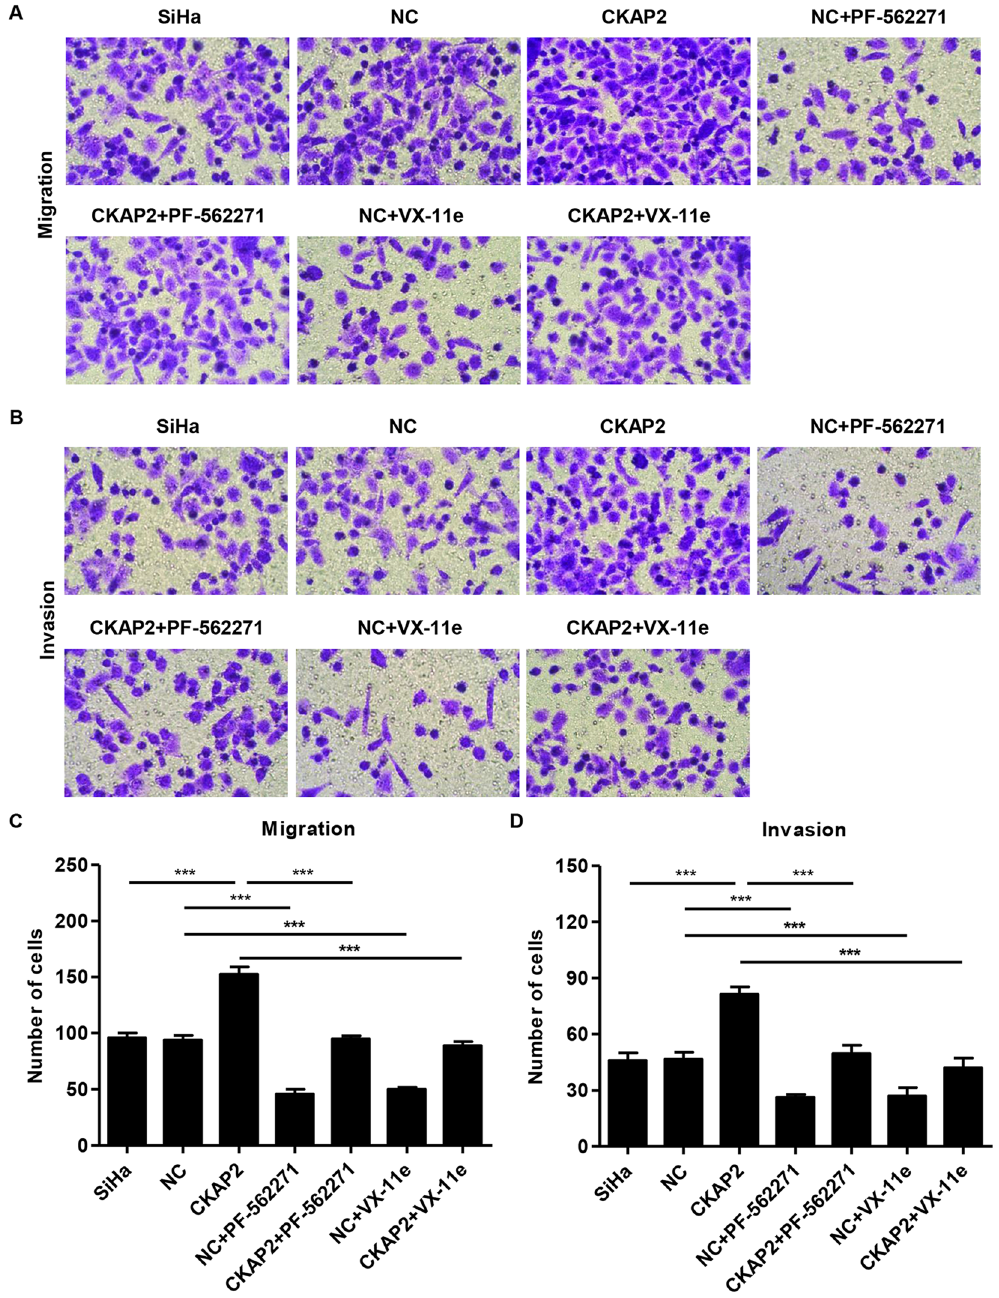
Figure 7. Effects of PF-562271 or VX-11e treatment on SiHa cell migration and invasion. ( A , C ) SiHa cells were treated with 10 μ M of PF-562271 or VX-11e, and cell migration was measured by Transwell assay. ( B , D ) SiHa cells were treated with 10 μ M of PF-562271 or VX-11e, and cell invasion was measured by Transwell Matrigel assay. *** P <